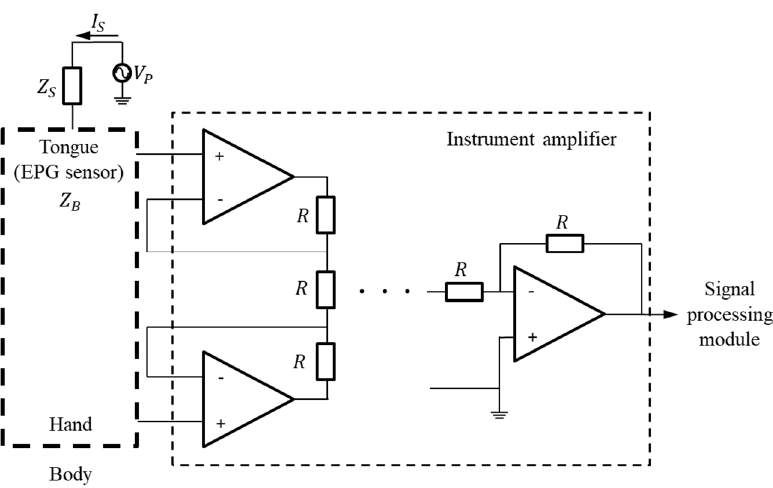
Figure 3. Block diagram for the measurement of signals based on tongue